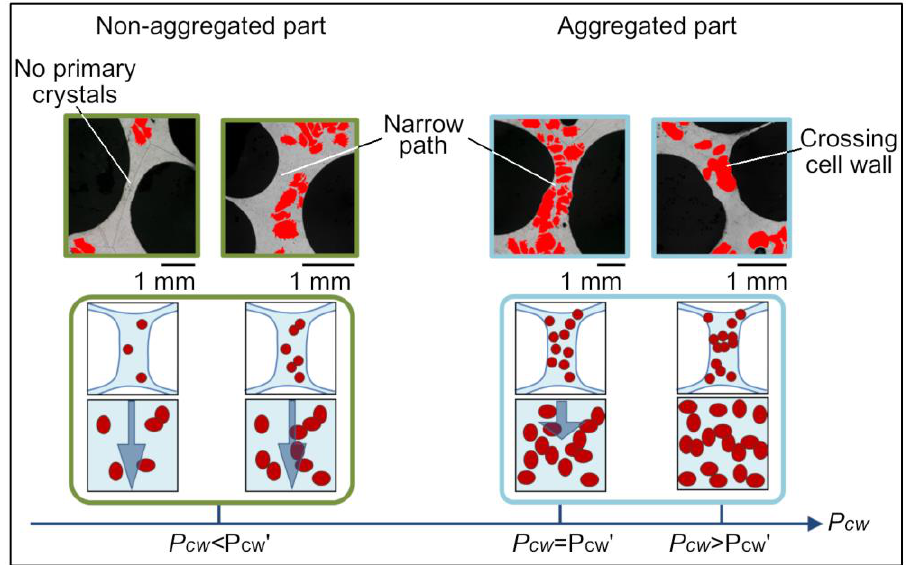
Figure 11. Scheme showing percolation theory of stable cell walls. In the upper microscopic images, the primary crystals were filled with red color. P cw is the percolation probability for the cell walls. P cw ′ is the percolation threshold of the cell wall model.